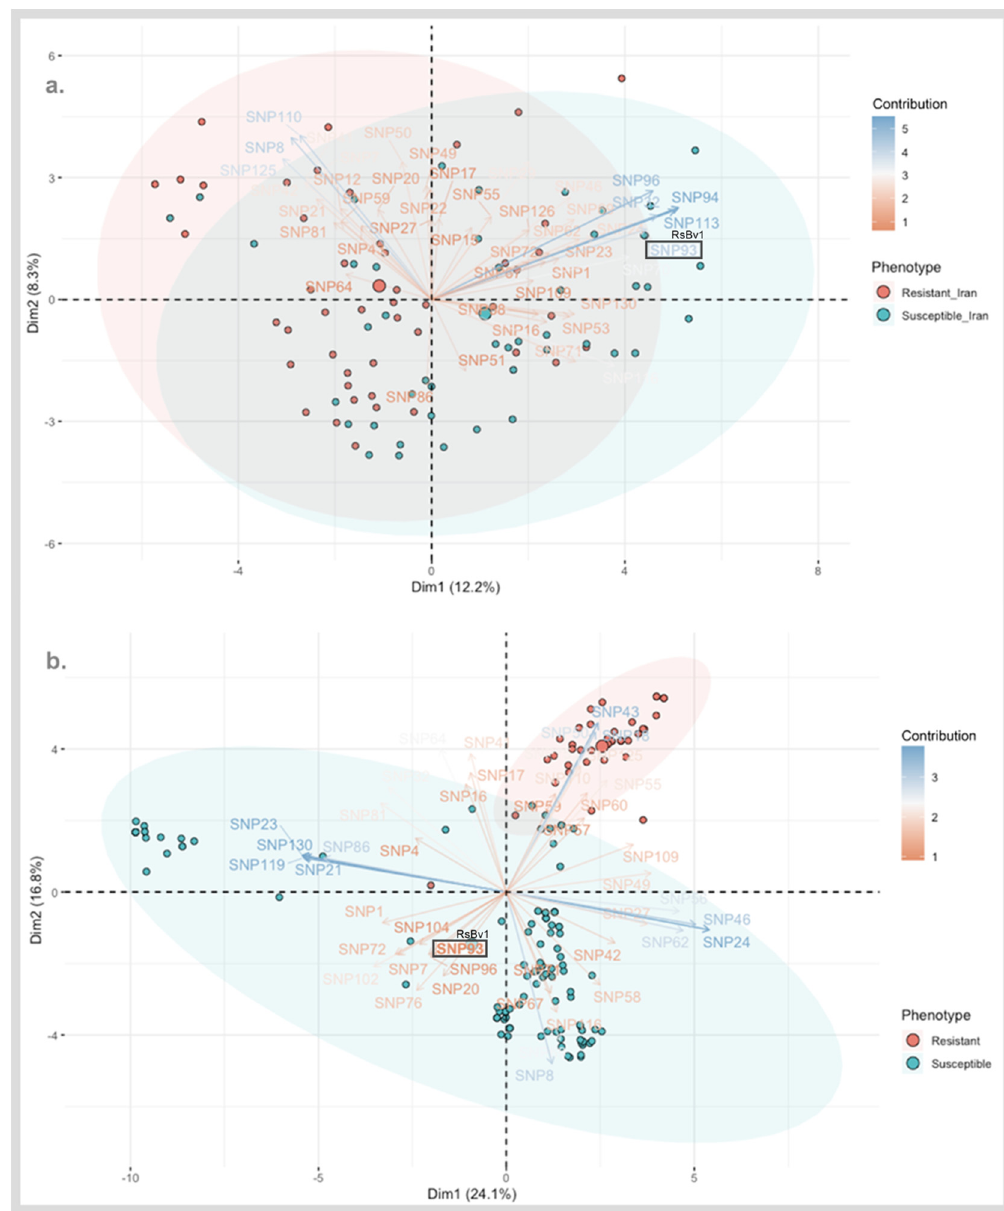
Figure 3. ( a ) PCA ‐ biplot of selected 297 SNPs from the association analysis estimated 20.5% of phenotypic variation in SBSI germplasm. ( b ) PCA ‐ biplot of selected 297 SNPs from the association analysis estimated 40.9% of phenotypic variation in Strube Research germplasm. Clusters of individuals on the same side of a given variable (SNP) have a higher value for the same (encoded as 0 for reference allele, 1 for heterozygous calls and 2 for alternate allele). For example, the contribution of RsBv1 in the opposite direction of resistant clusters is seen indicating that the majority of the resistant plants have the alternate allele.